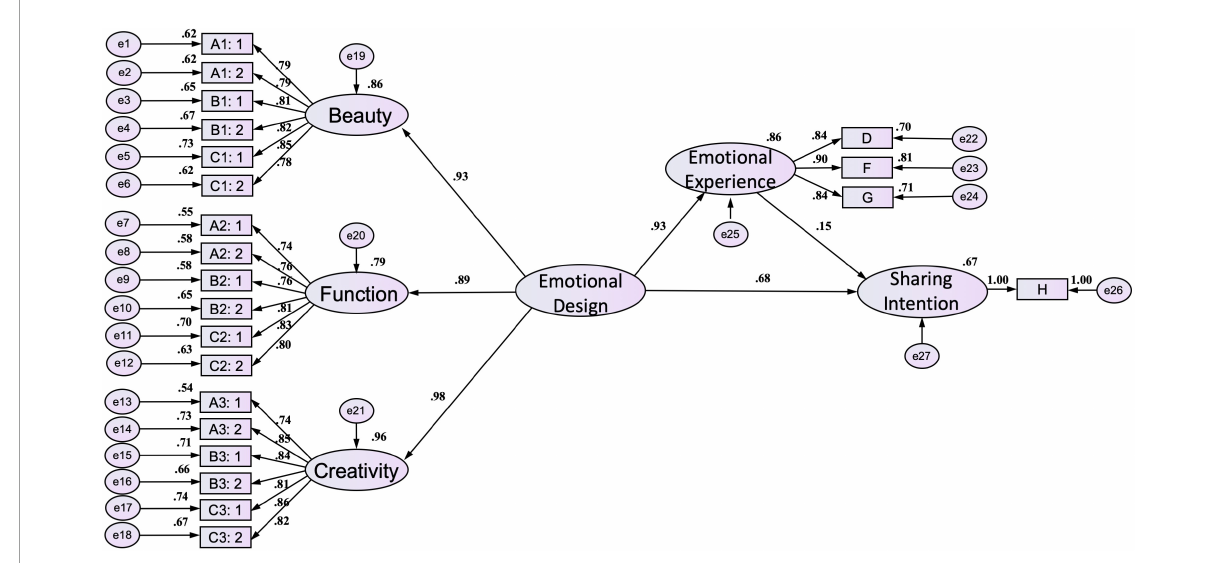
FIGURE4 Path diagram of musical works structure model in the research.